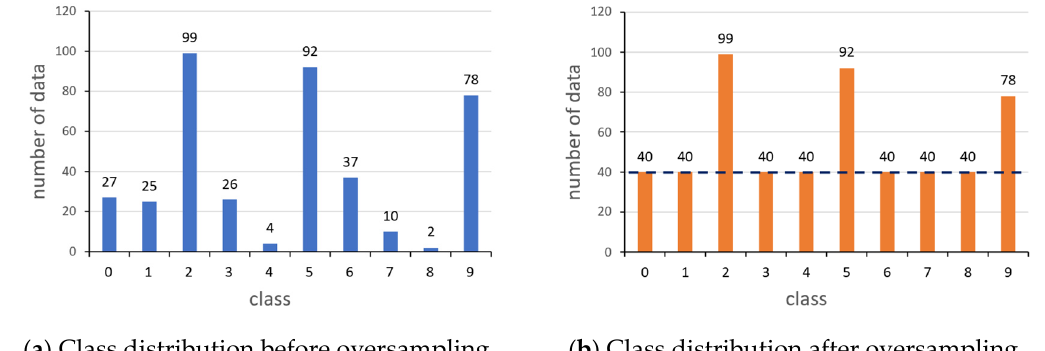
Figure 1. Class data distribution through data oversampling, where the dotted line in ( b ) is the average amount of data per